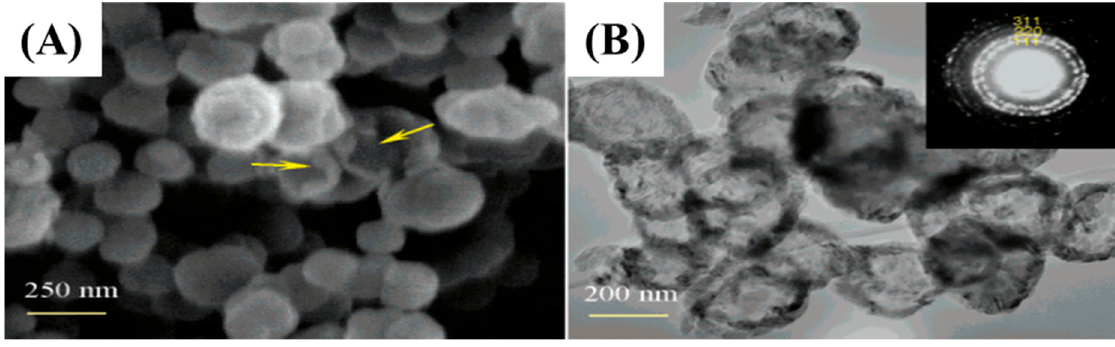
Figure 4. FE-SEM and TEM images ( A , B ) of hollow SiC NPs [45].